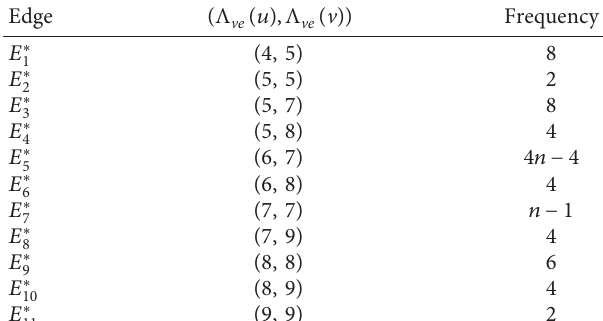
Table 6: End vertices’ ve-degrees of each edge of H